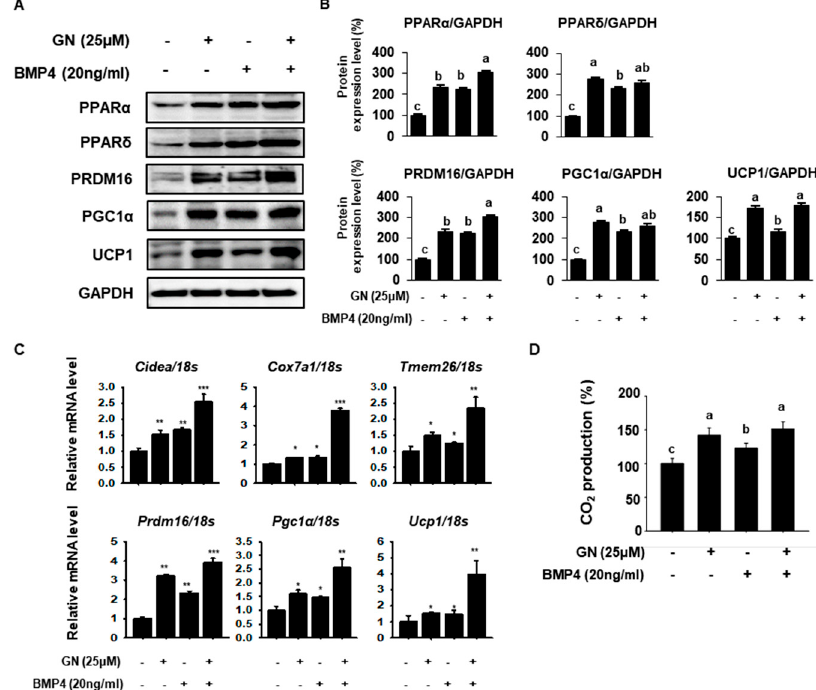
Figure 5. Synergistic effects of BMP4 and GN on thermogenesis in 3T3-L1 cells. ( A,B ) Western blotting for the browning factors PPAR α , PPAR δ , PRDM16, PGC1 α and UCP1 in 3T3-L1 cells and band density quantification. All data are expressed as mean ± SD ( n = 4) and values with different letters are significantly different, p < 0.05 (a > b > c > d). ( C ) Relative mRNA expression levels of the thermogenic genes Cidea , Cox7a1 , Tmem26 , Prdm16 , Pgc1 α and Ucp1 were determined by qPCR and normalized to 18S rRNA expression. ( D ) Relative CO 2 production was analyzed using a carbon dioxide assay kit according to the manufacturer’s instructions. mRNA data are expressed as mean ± SD ( n = 4) and values with different letters are significantly different * p < 0.05, ** p < 0.01, *** p < 0.001. BMP4; Bone morphogenetic protein 4.